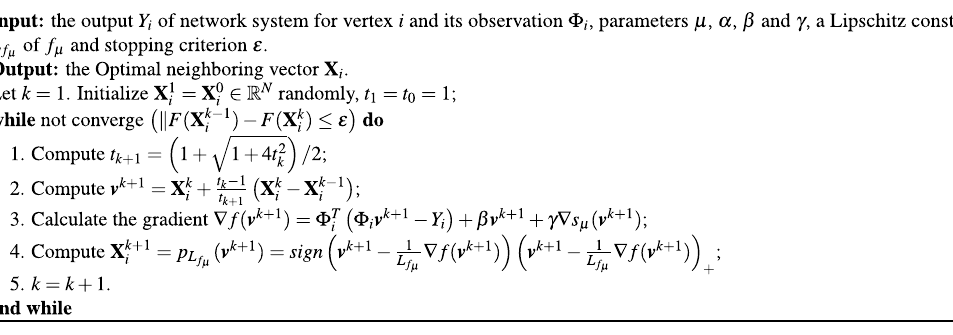
Algorithm 1. The main procedures of solving the problem